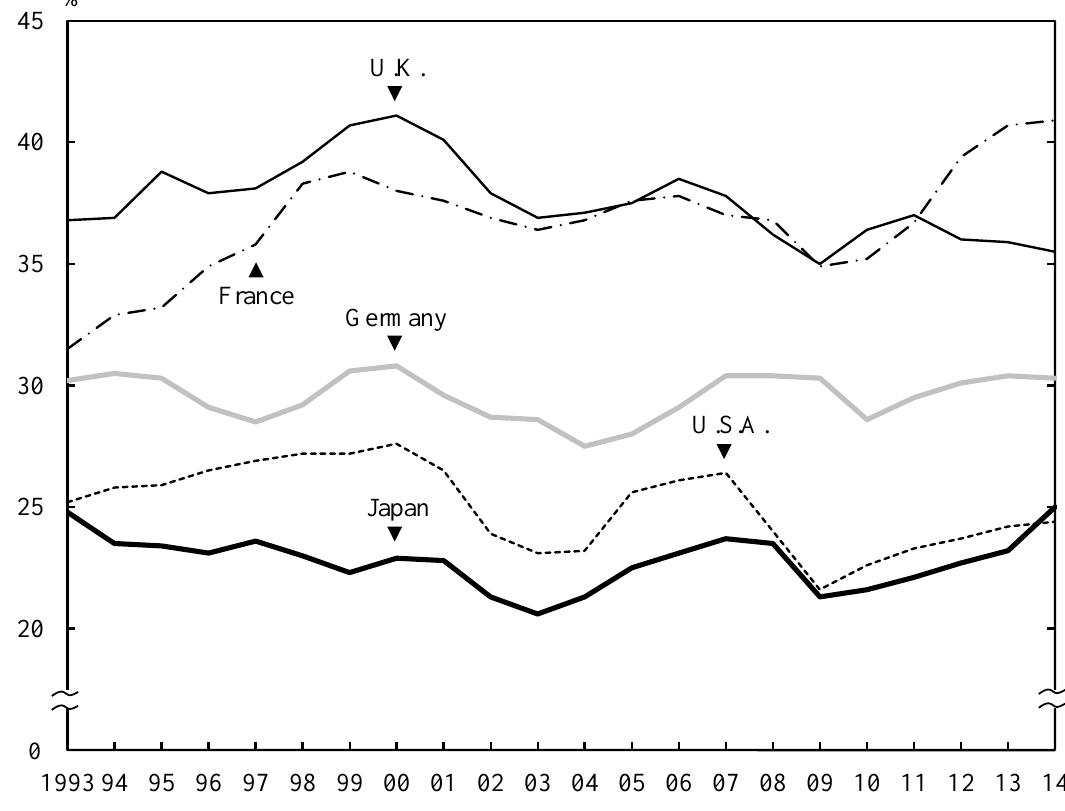
Source: Ministry of